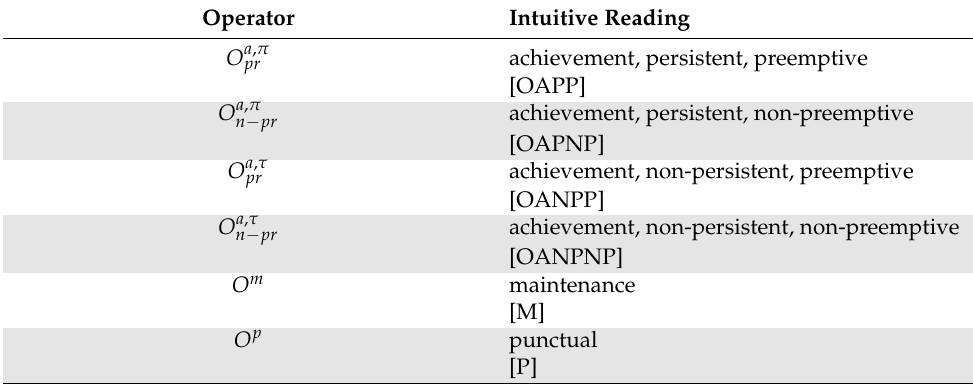
Table 12. PCL obligation operators (adopted from [37]).